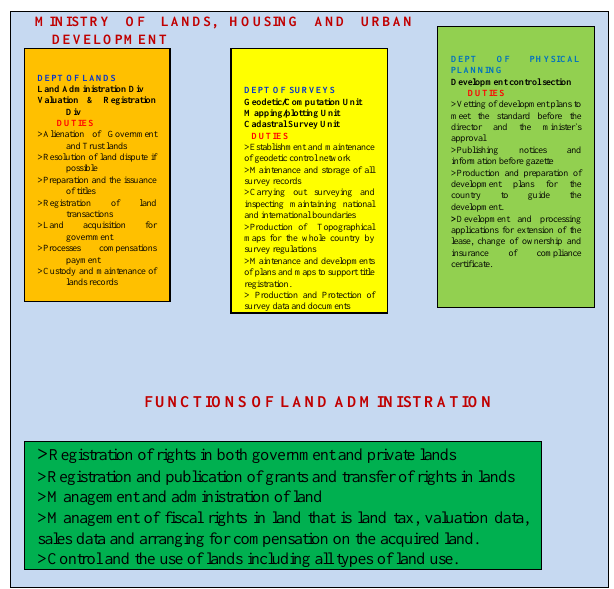
Figure 2. Organization structure of the Ministry and their